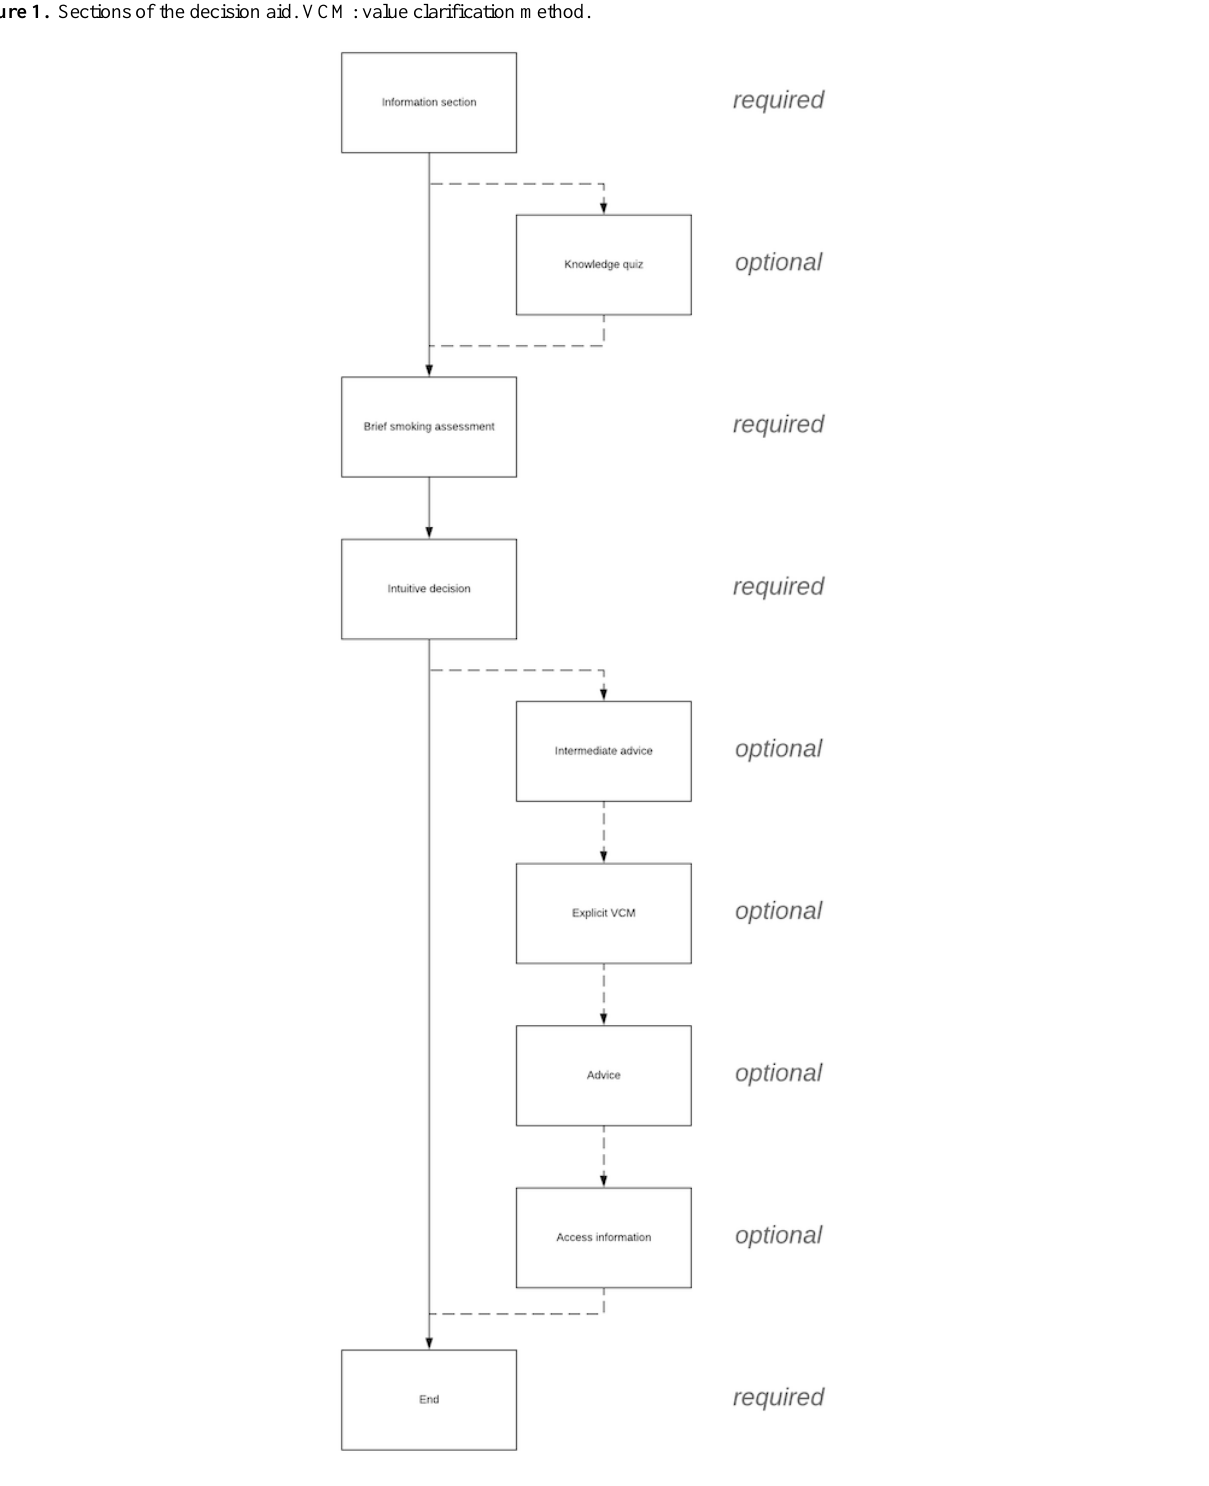
Figure 1. Sections of the decision aid. VCM: value clarification